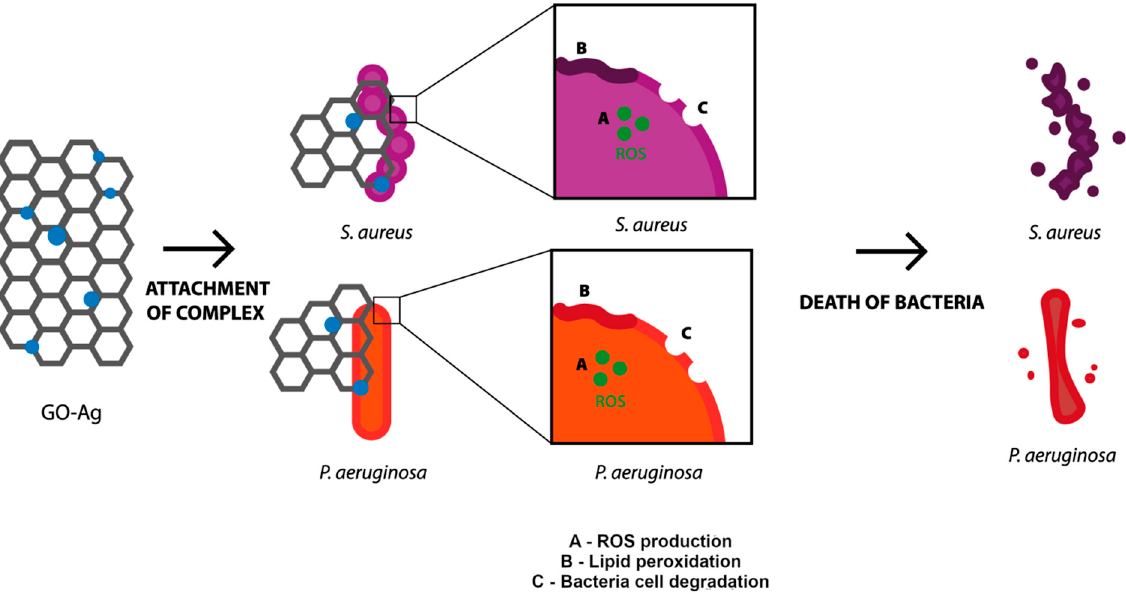
Figure 8. The mechanism of action of GO-Ag nanocomposite toward bacterial cells, including attachment of the complex, generation of ROS, lipid peroxidation and degradation of outer layer of bacteria resulting in bacteria death.